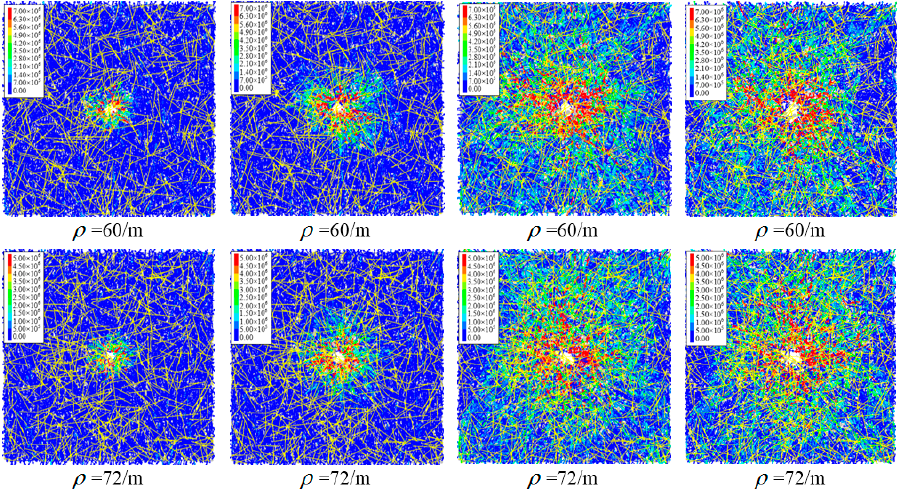
Figure 18. Evolution process of injection pressure induced by NF densities of rock formations when injection rate is 2.0 × 10 − 6 m 3 /s and S H : S h = 10:5.